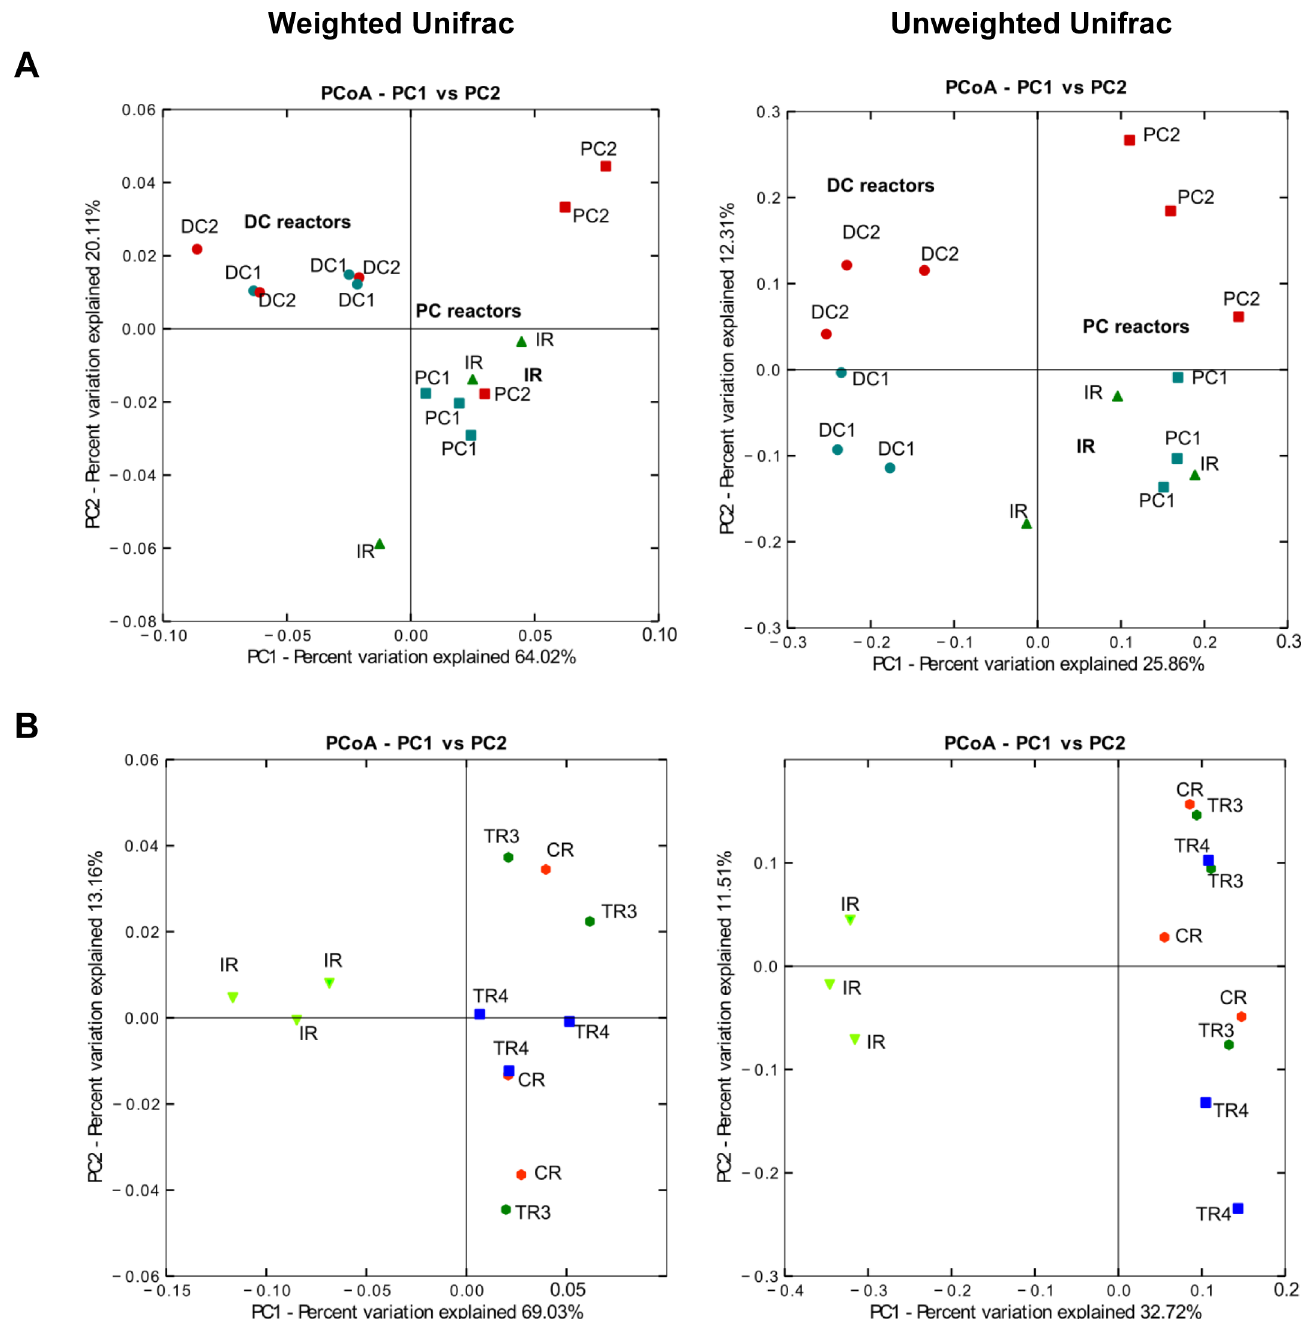
Fig 3. PCoA analysis of PolyFermS models based on weighted and unweighted UniFrac analysis. Each symbol is representing a different reactor. (A) Three last days at the end of the stabilization period of all reactors of model 2 (IR, PC1, DC1, PC2 and DC2) and (B) three last days at the end of the stabilization period of model 3 (IR, CR, TR3 and